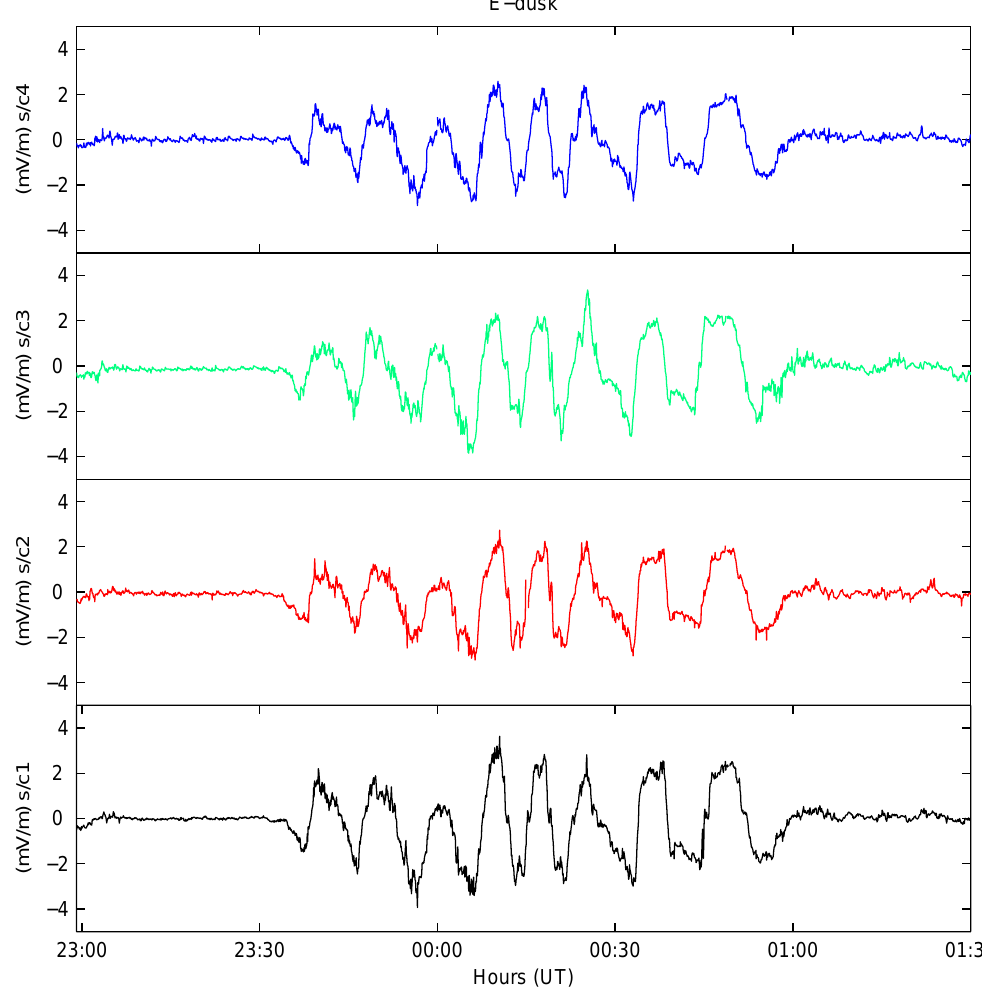
Fig. 3. Duskward electric field measured by s/c 1 (black), s/c 2(red) s/c 3 (green), s/c 4 (blue).